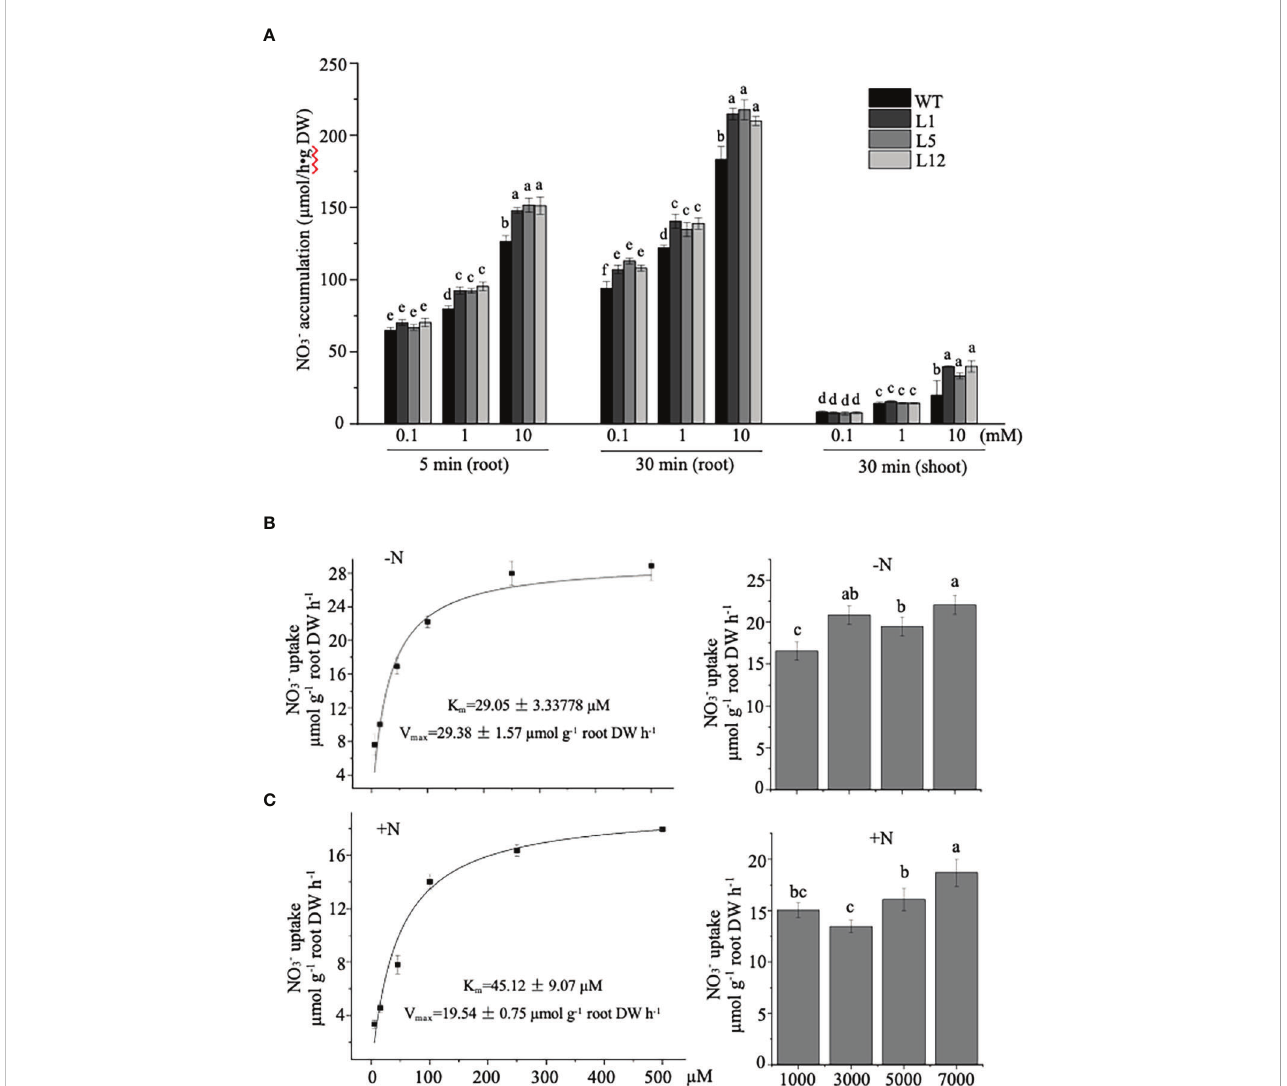
FIGURE 6 Measurement of nitrate in fl ux into roots of NtNRT1.1B -expressing lines and their WT tobacco. (A) Time-dependent 15 N-labeling NO − 3 absorption by roots of NtNRT1.1B -expressing lines and their WT. 15 N-NO − 3 uptake by roots was conducted with NtNRT1.1B -overexpressing lines (L1, L5, and L12) and their WT (K326) cultivated hydroponically for 4 weeks and then starved of N for 2 days. The exposure of the roots for 5 min or 30 min in an N-free nutrient solution supplied with NO − 3 at three concentrations (0.1, 1.0, or 10 mM) was designed for the in fl ux measurement. A detailed protocol for the tobacco growth and root uptake study is provided in Materials and methods. Tracer 15 N-NO − 3 with 99.72% 15 N abundance (K 15 NO 3 ) was applied (note that, for the 10 mM NO − 3 supply, only 10% N in the form of 15 NO − 3 was added to the uptake assay solution). The 15 N incorporated into plant samples (3 – 4 mg roots or shoots) was analyzed by using mass spectrometry (see Materials and methods) and was converted into NO − 3 absorbed by the roots. The mean values ± standard deviation (SD) ( n = 4 biological replicates) are shown, and statistically signi fi cant differences are indicated by different letters [ P < 0.05 by one-way analysis of variance (ANOVA)]. DW, dry weight. (B, C) Concentration-dependent short-term in fl ux of 15 NO − 3 into roots of NtNRT1.1B - expressing line and its WT. After germination of seeds on 1/2 MS agar plates for 14 days, seedlings were transferred to a normal nutrient solution for 7 days of growth. Roots of 2-day N-starved plants or those grown with the normal nutrient solution were used in the in fl ux assay; the roots were supplied with 5,000 – 7,000 m M NO − 3 (in the form of 100% 15 NO − 3 or partially containing 15 NO − 3 ; see Materials and methods) for 3 min (to minimize the long- distance movement of nitrate absorbed). Values are differences in 15 NO − 3 accumulation in the WT transformed with or without NtNRT1.1B (the NtNRT1.1B -overexpressing line1/L1 was used). The in fl ux of nitrate into roots via NtNRT1.1B was saturable and displayed Michaelis-Menten kinetics with a half-maximal saturation at around 30-45 µM nitrate (i.e. an af fi nity constant Km of NtNRT1.1B for nitrate). The mean values ± SE ( n = 5 or 6) are shown, and different letters above the bars indicate statistically signi fi cant differences [( P < 0.05 by one-way analysis of variance (ANOVA)]. 15 N incorporated in the roots was analyzed by using mass spectrometry and converted into NO − 3 taken up by the roots. “– N ” , 2-day N-starved plants; “ +N ” , plants grown continuously with normal nutrient solution. A very similar result was also observed in NtNRT1.1B -transgenic line 5 (L5; see Supplemental Figure